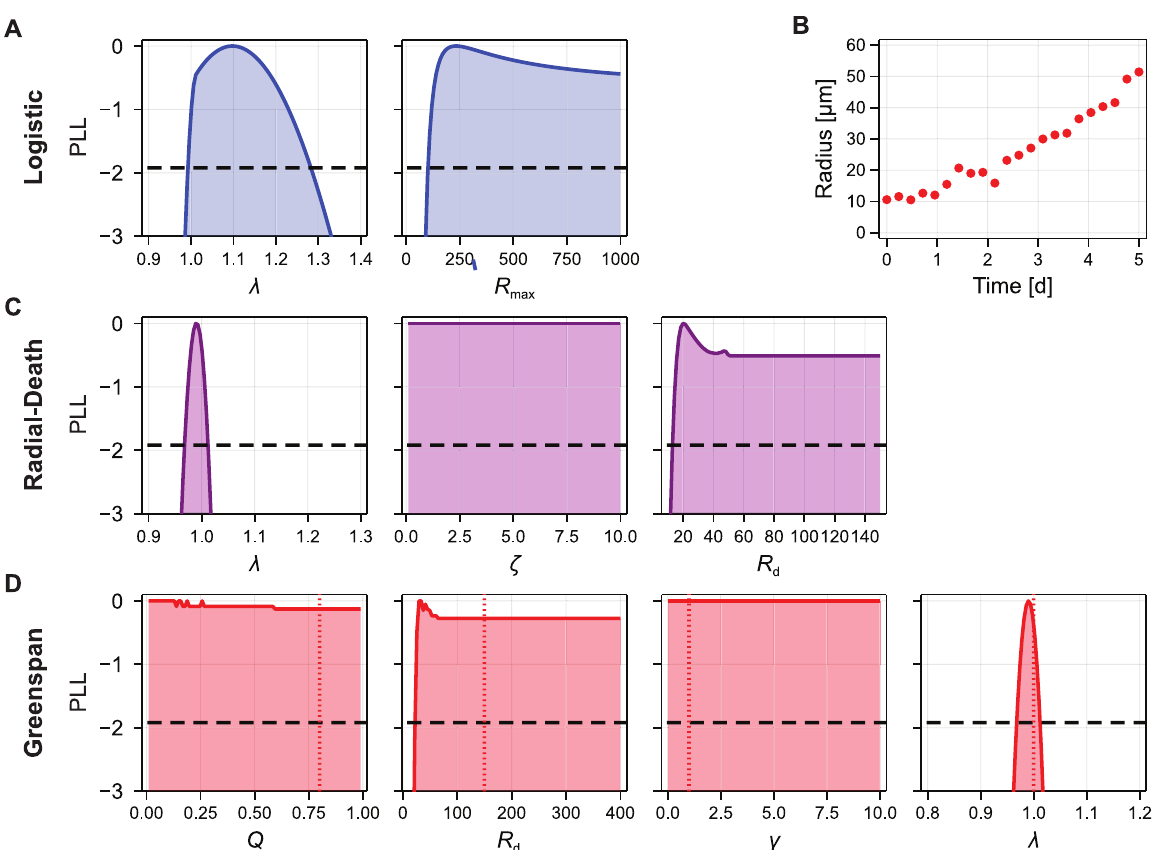
Fig 7. Identifiability analysis for the logistic, radial-death, and Greenspan models using early-time data. (A,C,D) Profile likelihood for the parameters in each model, using synthetic data generated from the Greenspan model with standard deviation σ = 2 μ m. Synthetic data is shown in (B). Also shown is the threshold for an approximate 95% confidence interval (black-dashed). For the Greenspan model, we additionally show the parameter values used to generate the synthetic